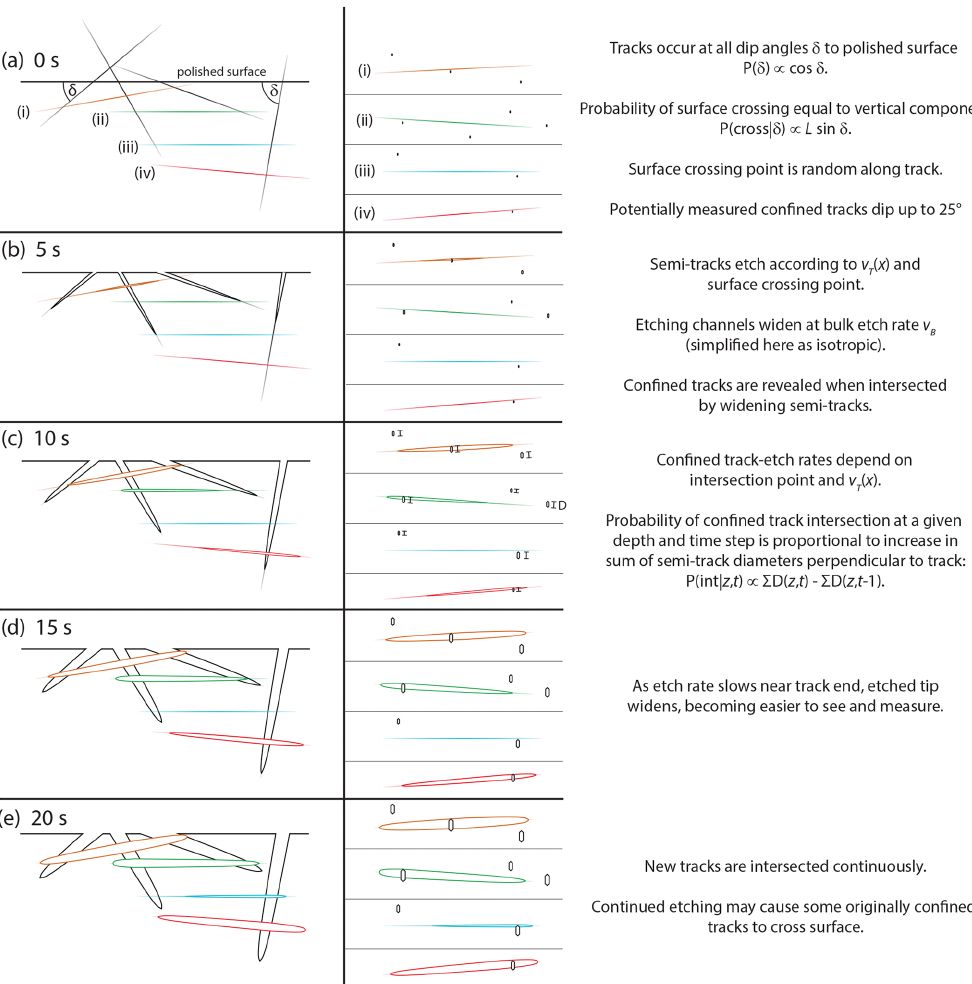
Figure 4. Schematic overview of the TINT revelation model through successive etching times of 0 through 20s (a) – (e) . Semi-tracks are shown in gray, and confined tracks are shown in colors to facilitate matching tracks in side view versus overhead section view. Overhead sections are in the sometimes-oblique plane of the confined track, as it is the expansion of the semi-track in that plane that leads to intersection. Variations in latent track brightness indicate relative etching velocity. Etchant pathways in overhead view are depicted as anisotropic prisms, but the present model effectively simplifies them as circles because track orientation is not